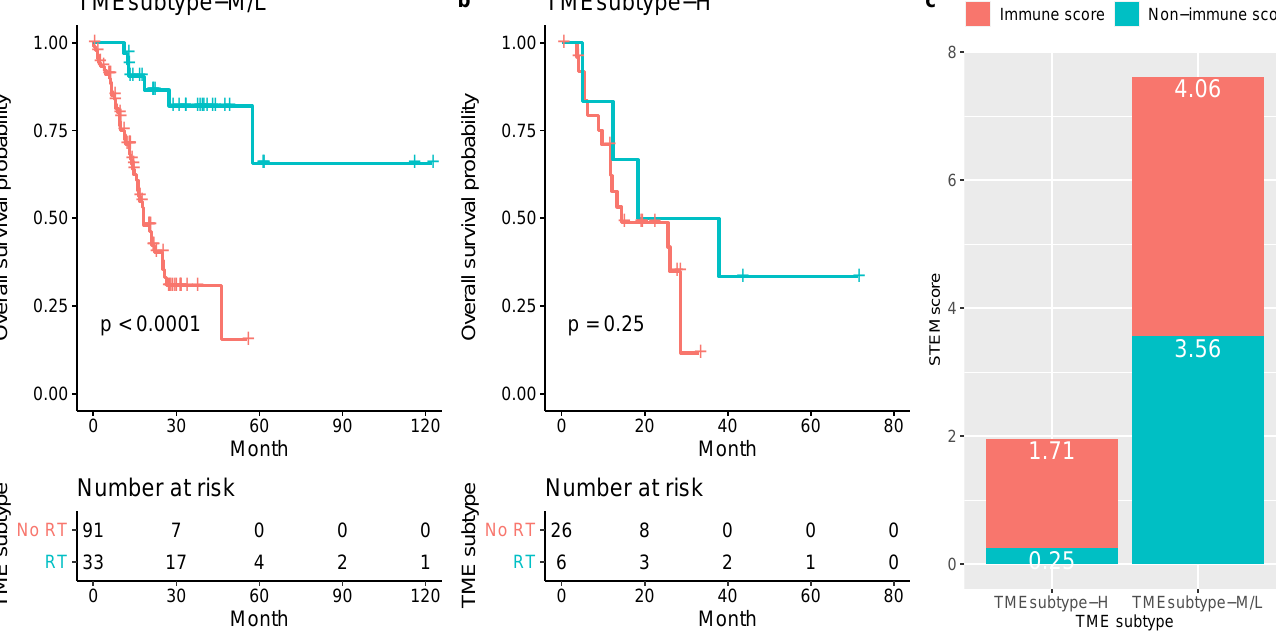
Figure 19. Relationship between the TME subtypes and survival benefit from radiation therapy in matched patients with stage III gastric cancer: ( a ) TMEsubtype-H, ( b ) TMEsubtype-M/L. ( c ) Compare the mean non-immune and immune scores of patients in the TMEsubtype-H to the TMEsubtype-M and -L for stage III disease in the TCGA-STAD